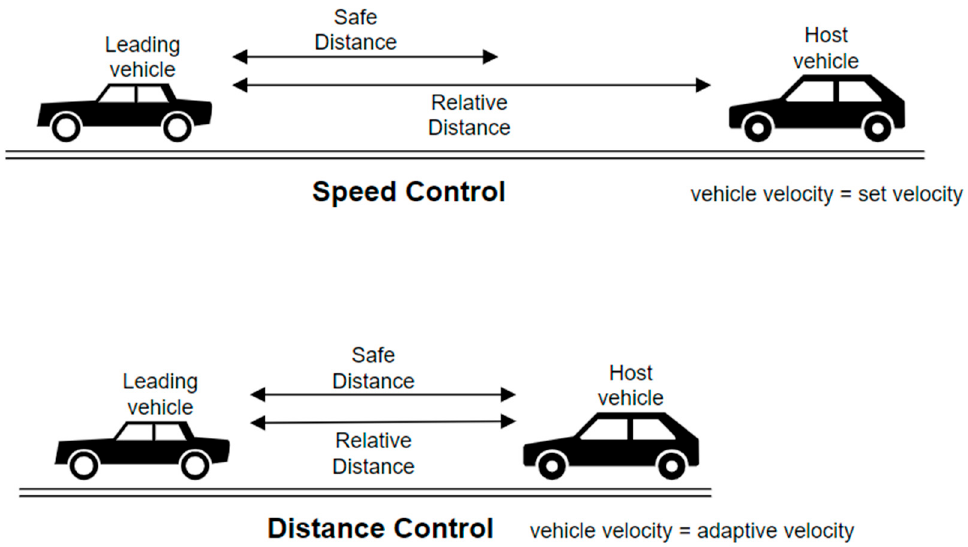
Figure 1. Working modes of adaptive cruise control.